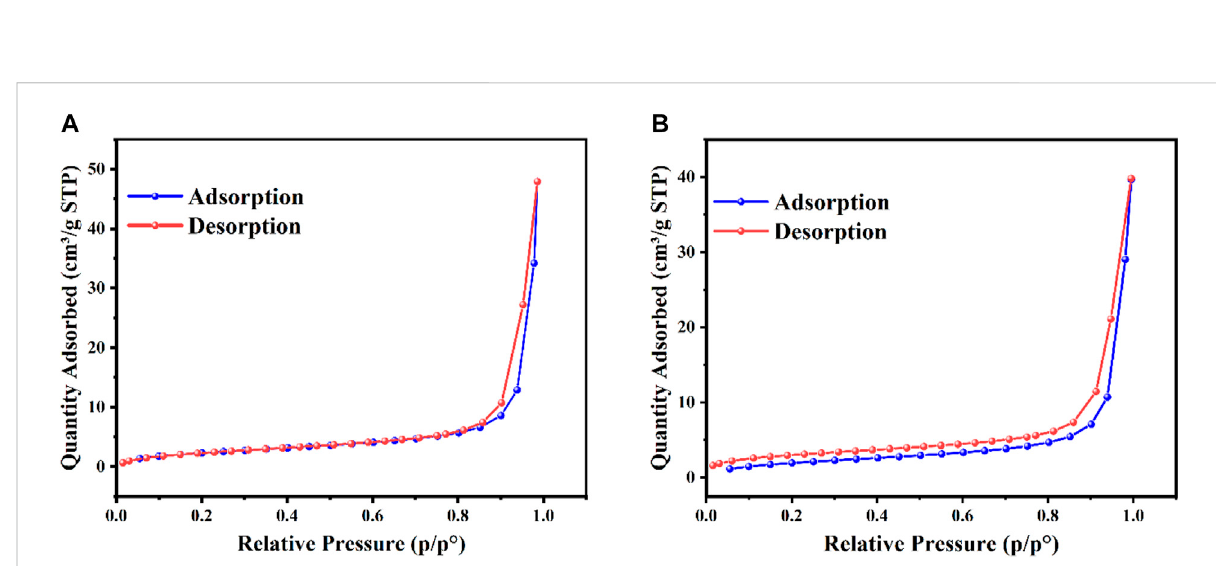
FIGURE 4 Nitrogen adsorption-desorption isotherms: (A) AgO/Ag 2 O, (B) MgO@AgO/Ag 2 O